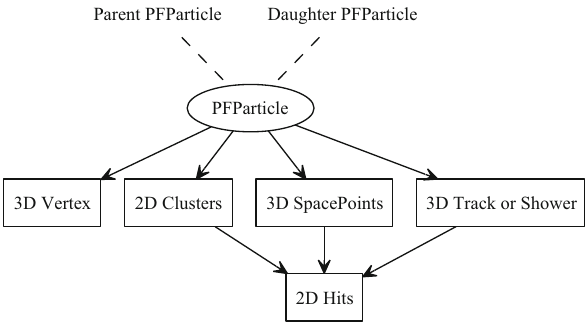
Fig. 1 The Pandora output data products, as persisted in the LArSoft Event Data Model. Navigation along PFParticle hierarchies is achieved using the PFParticle interface, represented by dashed lines. Naviga- tion from PFParticles to their associated objects is represented by solid